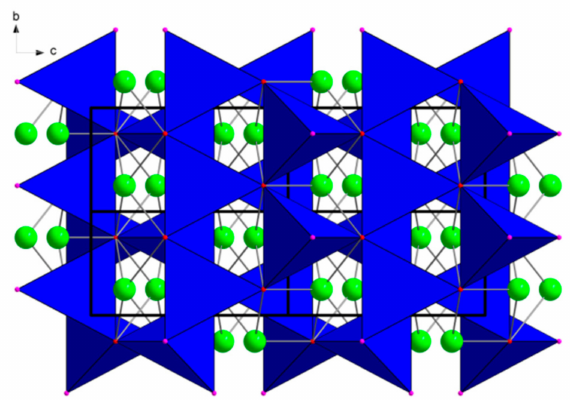
Figure 5. Coordination environment of M 1 (left) and M 2 (right) sites in the crystal structure of grammatikopoulosite. Colors and symbols as in Figure 4.